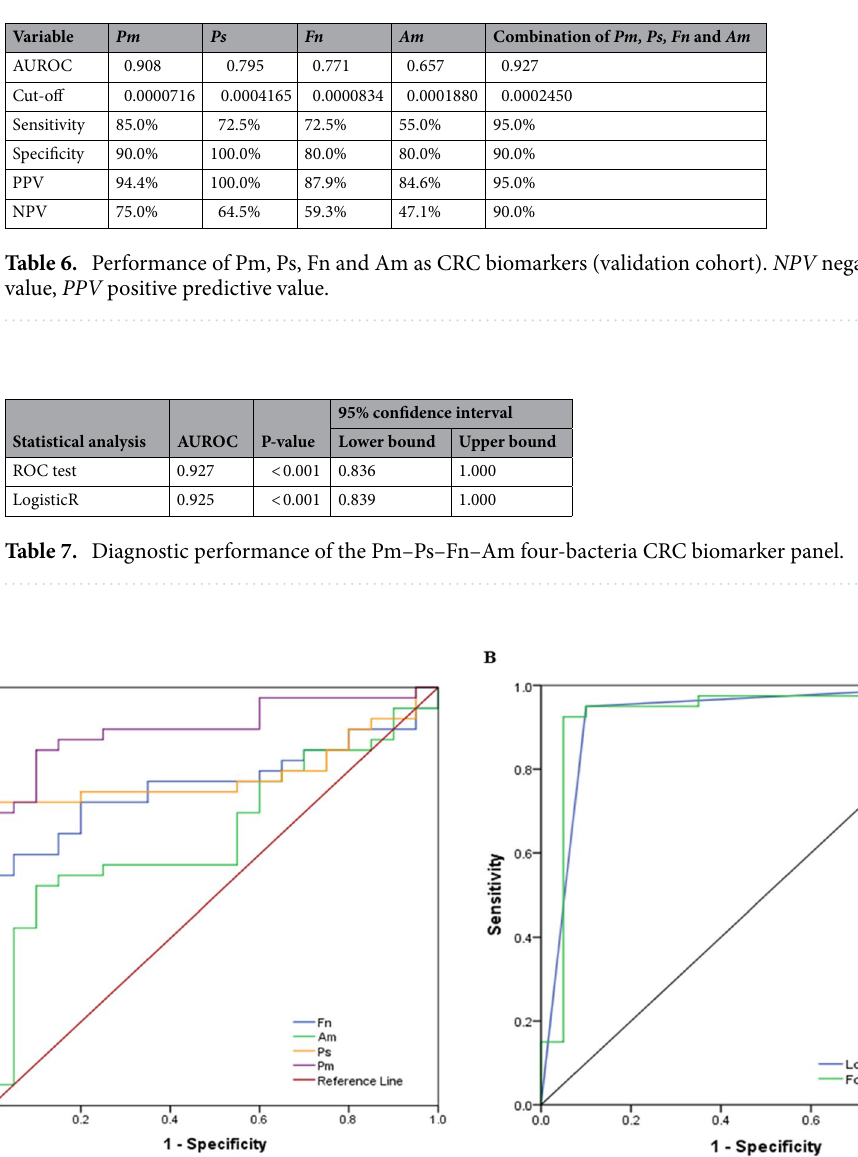
Figure 4. Diagnostics performance of the Pm-Ps-Fn-Am qPCR four-bacteria CRC biomarker panel. (A) ROC curves for Pm–Ps–Fn–Am in distinguishing CRC patients from non-CRC controls of the validation cohort. (B) ROC curves for the Pm–Ps–Fn–Am panel and probability plot values from the logistic regression (LogisticR)